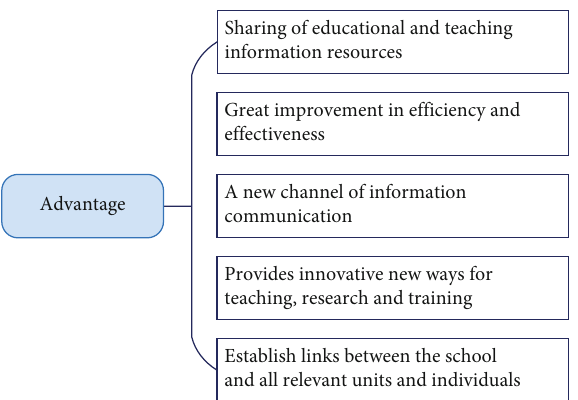
Figure 1: The advantages of the computer technology in the